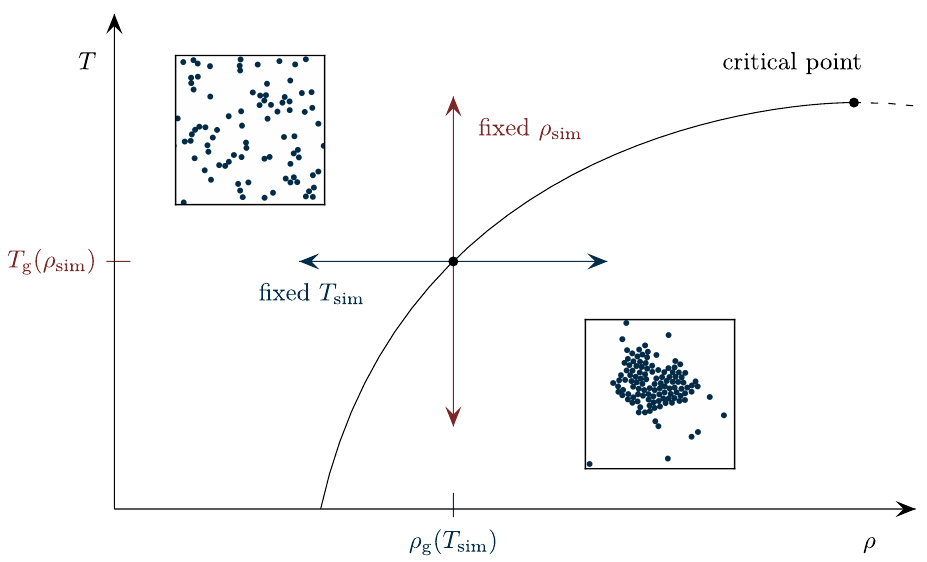
Figure 1: Sketch of the transition between the pure gas phase and the mixed phase of a liquid droplet surrounded by vapour. Below the critical point, the black infinite-size transition line can be crossed in either one of two orthogonal regimes : The blue hor- izontal arrow depicts the fixed-temperature approach in which density serves as the ( T ) is the infinite-size transition density. Alternatively, control parameter, where ρ g sim the red vertical arrow depicts the fixed-density approach in which temperature serves ( ρ ) is the infinite-size transition as the control parameter and T g sim